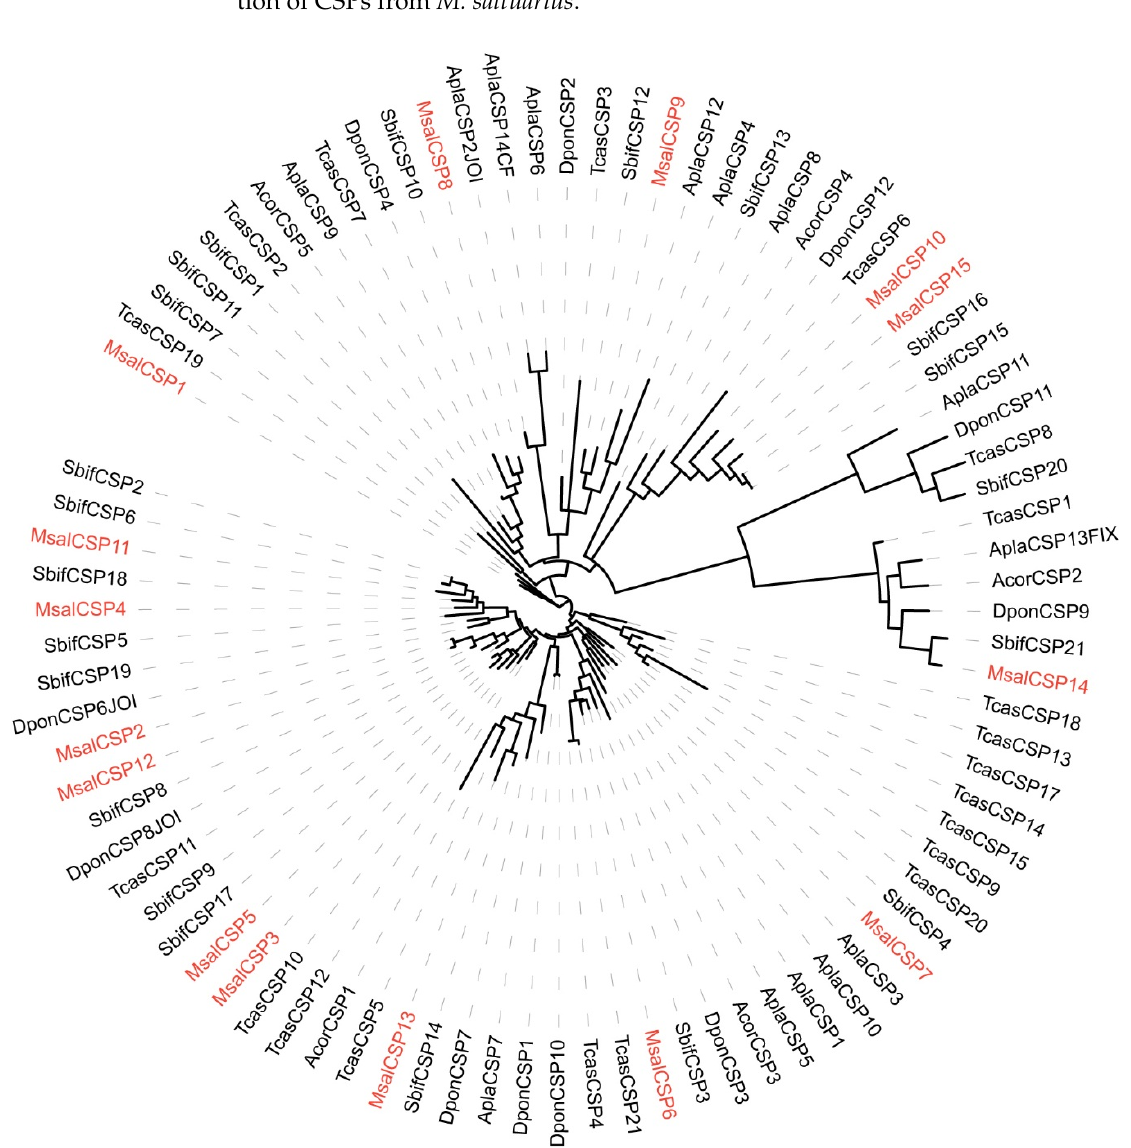
Figure 3. Expression patterns of chemosensory genes in healthy and B. xylophilus -infested M. sal- tuarius . ( A ) Differences between sexes of healthy M. saltuarius ; ( B ) Differences between healthy and infested female M. saltuarius ; ( C ) Differences between healthy and infested male M. saltuarius . Transcript levels are expressed as reads per kilobase of exon per million mapped reads (RPKM), and the expression data were shown as mean±SE. The stars above each bar of figure indicate sig- nificant differences ( p < 0.05 * and p < 0.05 **).